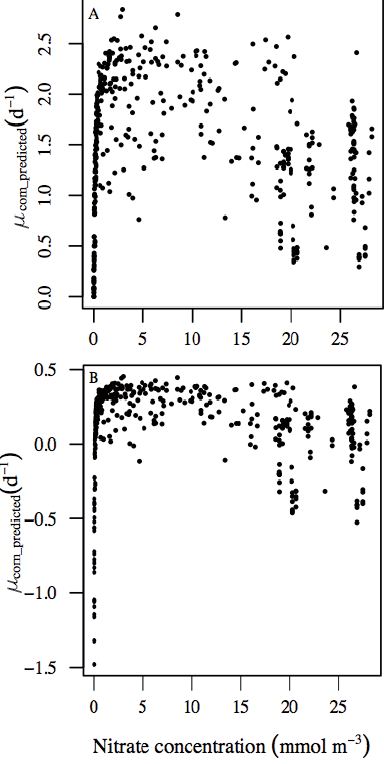
Figure 7. Relationships between the predicted community growth rates ( µ com_predicted , d − 1 ) and nitrate concentration (mmolm − 3 ) with (a) unimodal and (b) positive relationships between µ com_max and cell